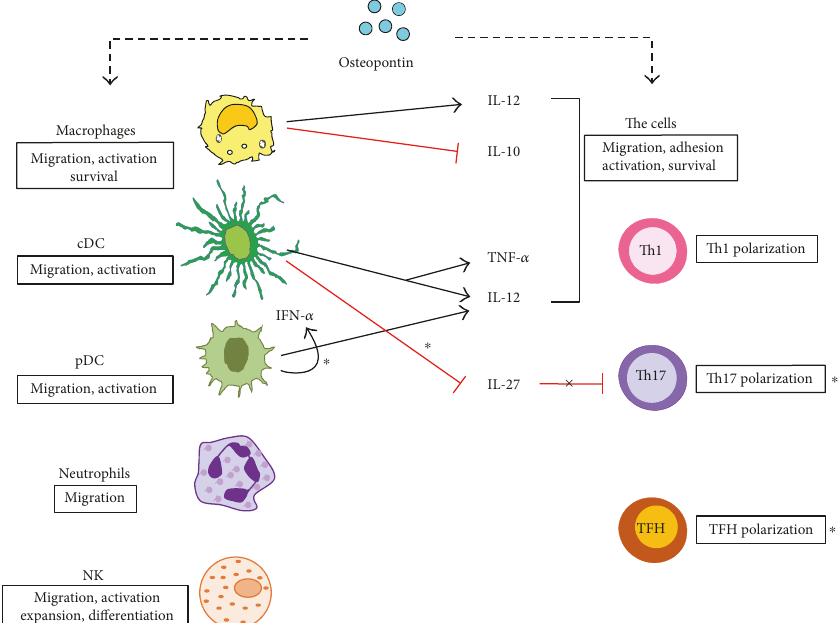
Figure 1: E ff ect of OPN on several leukocytes. sOPN triggers myeloid and lymphoid cells eliciting a functional response (boxes) that in turn induces cytokine secretion which drives the in fl ammatory/immune response. Asterisks mark the e ff ects mediated by